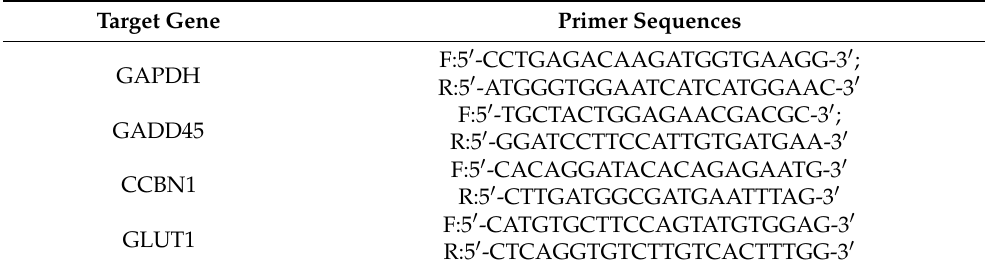
Table 1. Quantitative PCR primer